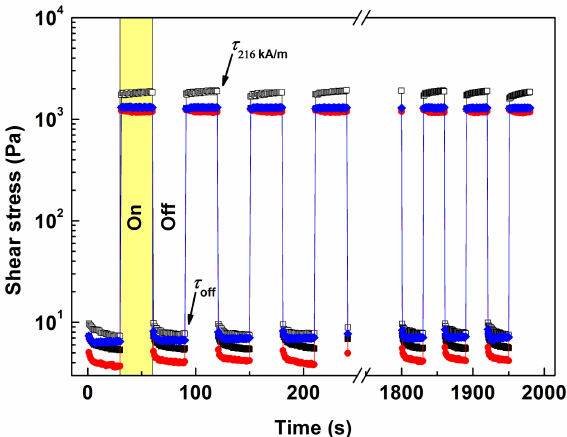
Figure 7. Shear stress response under a dynamic magnetic field (216 kA/m) for the reference MR fluid (white squares) and its bidisperse analogues supplemented with the neat NPs (black squares), NPs@TEOS (red circles) and NPs@m-TEOS (blue